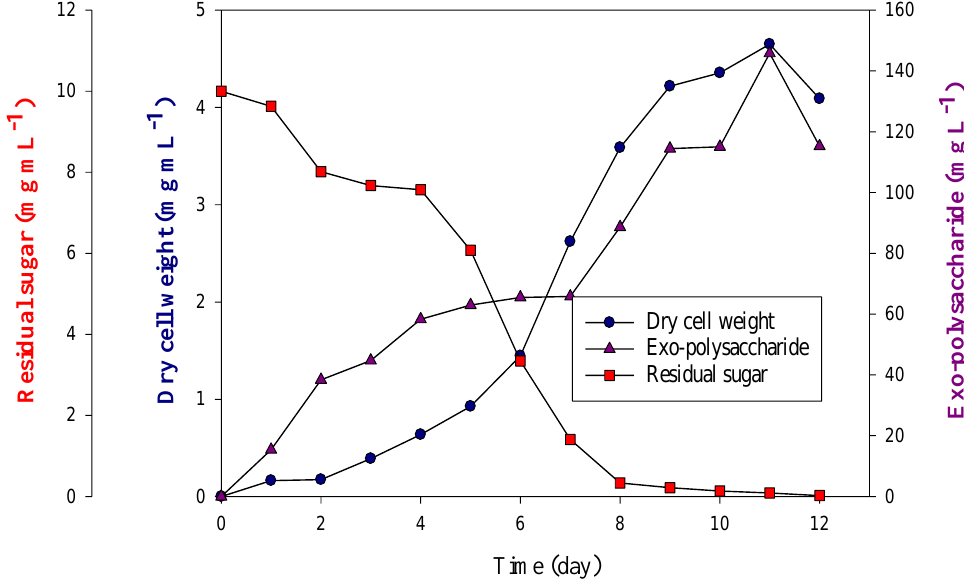
Figure 5. The effect of Tween 80 at 0.6 g/L on mycelia growth and EPS production in a 20 − L stirred tank bioreactor.